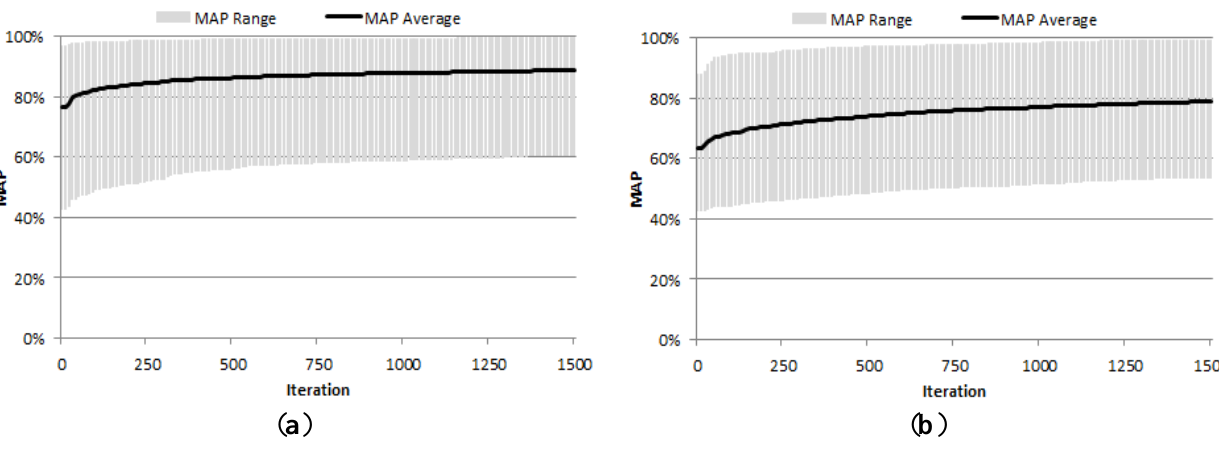
Figure 7. Range of MAP by iteration for the ( a ) training and ( b ) testing data sets when ranking images from the WROC data set using the Associative &